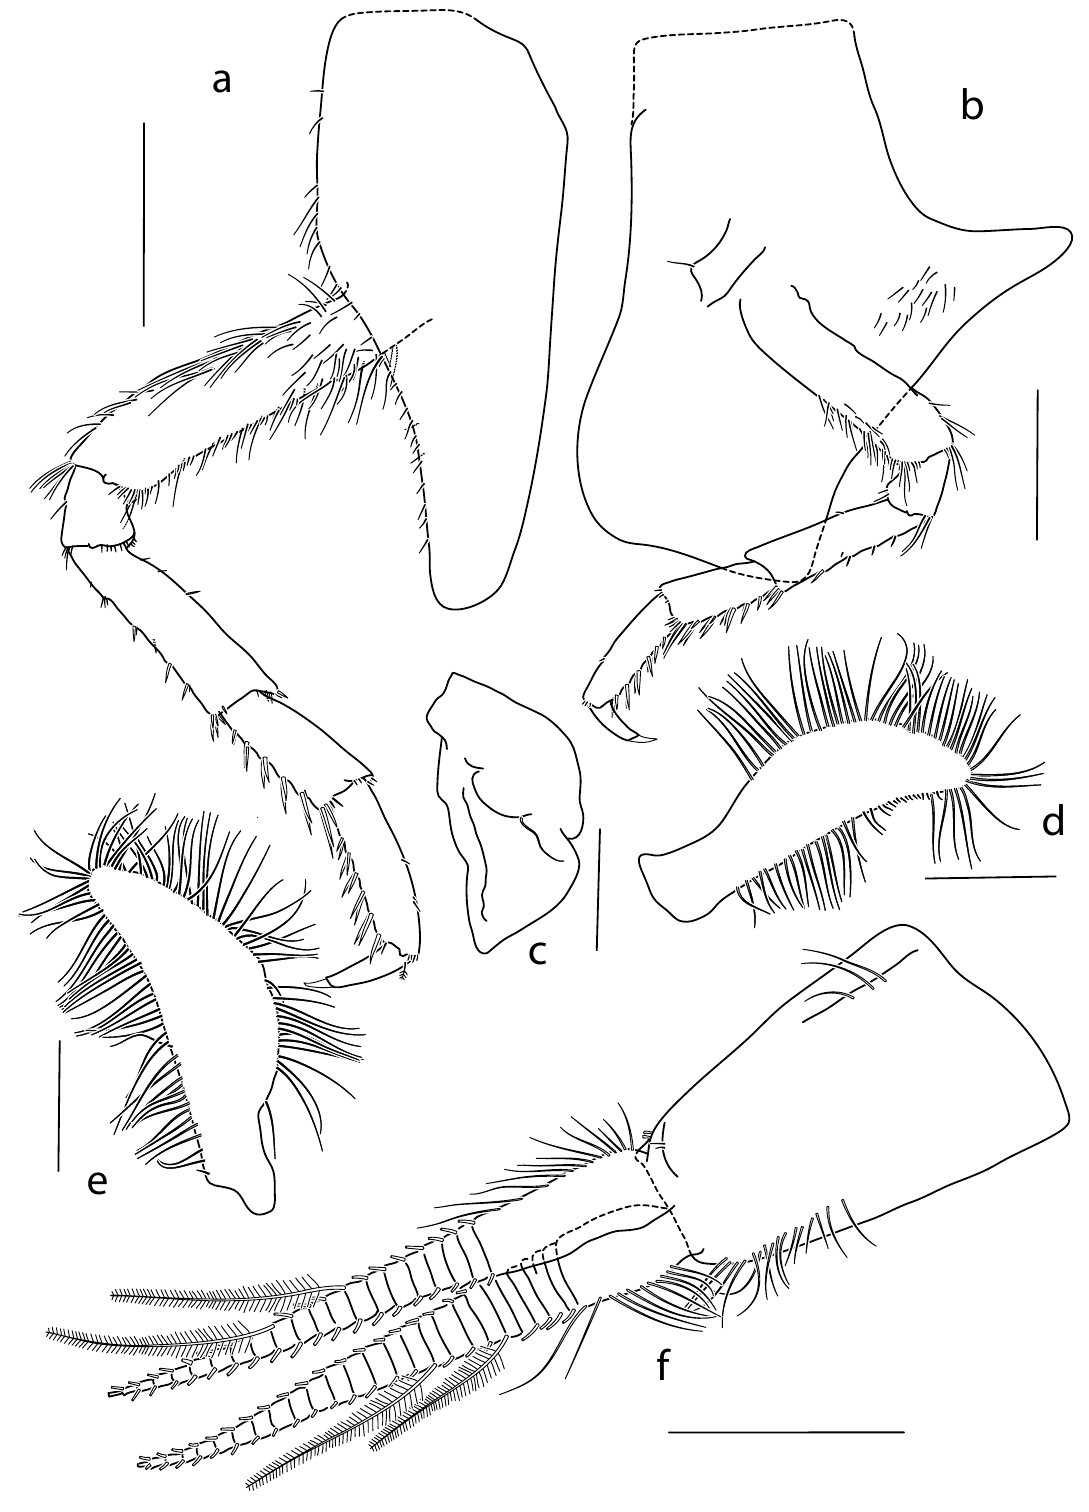
Fig. 16. Epimeria (Metepimeria) acanthurus (Schellenberg, 1931),♀, 22 mm (ZMB 34099). a . Pereopod 3. b . Pereopod 4, medial aspect. c . Gill of pereopod 4. d . Oostegite of pereopod 5. e . Oostegite of pereopod 3. f . Pleopod 1. Scale bars = 1